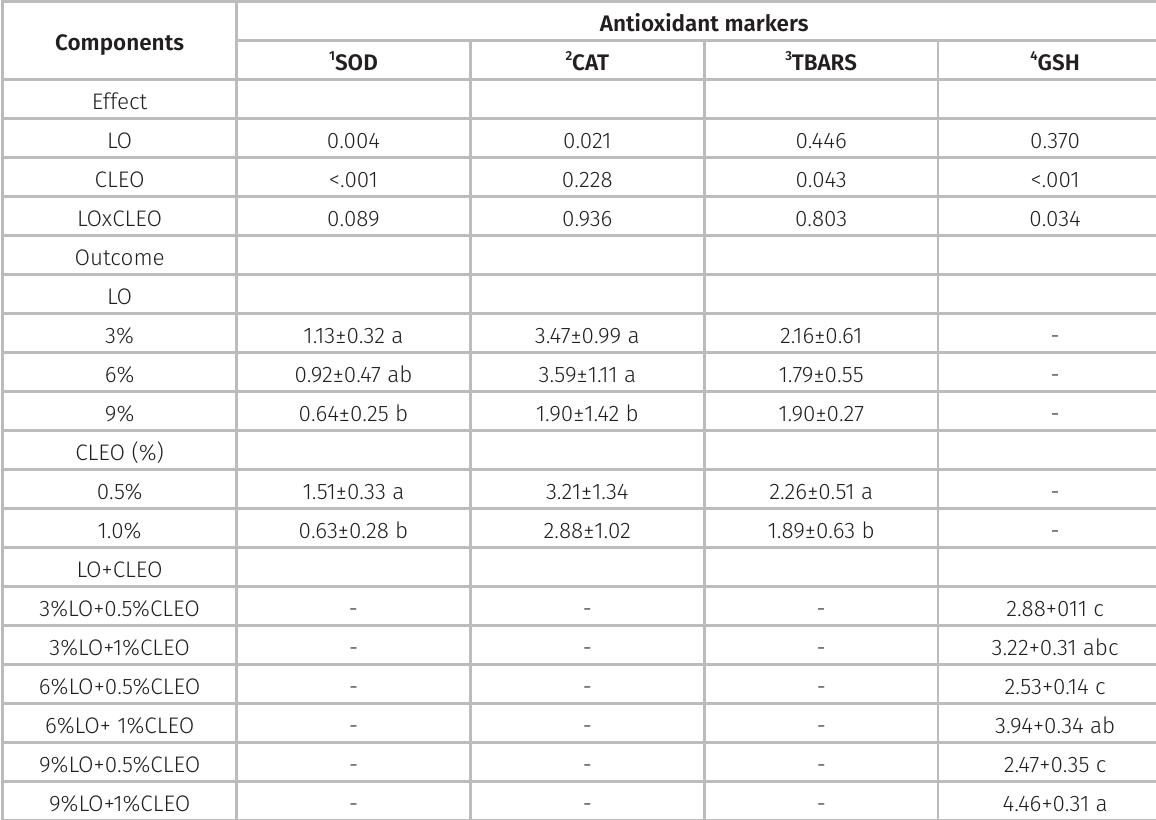
Table VI. Antioxidant and lipid peroxidation markers (TBARS) assessed in zebrafish ( Danio rerio ) fed experimental diets containing linseed oil (LO) and clove leaf essential oil